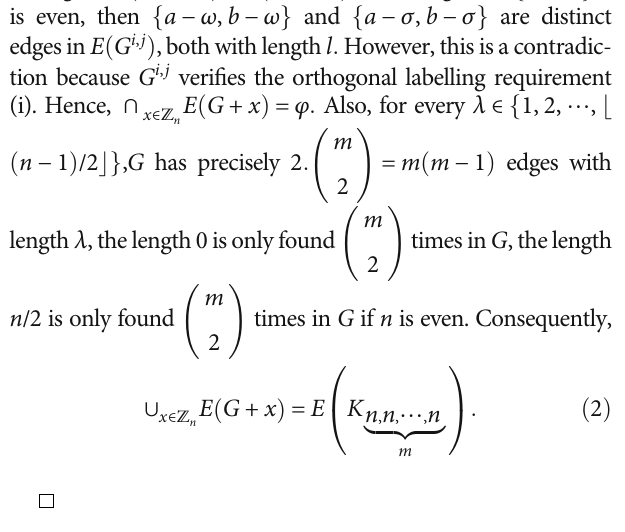
. , n , ⋯ , n |fflfflfflffl{zfflfflfflffl} m